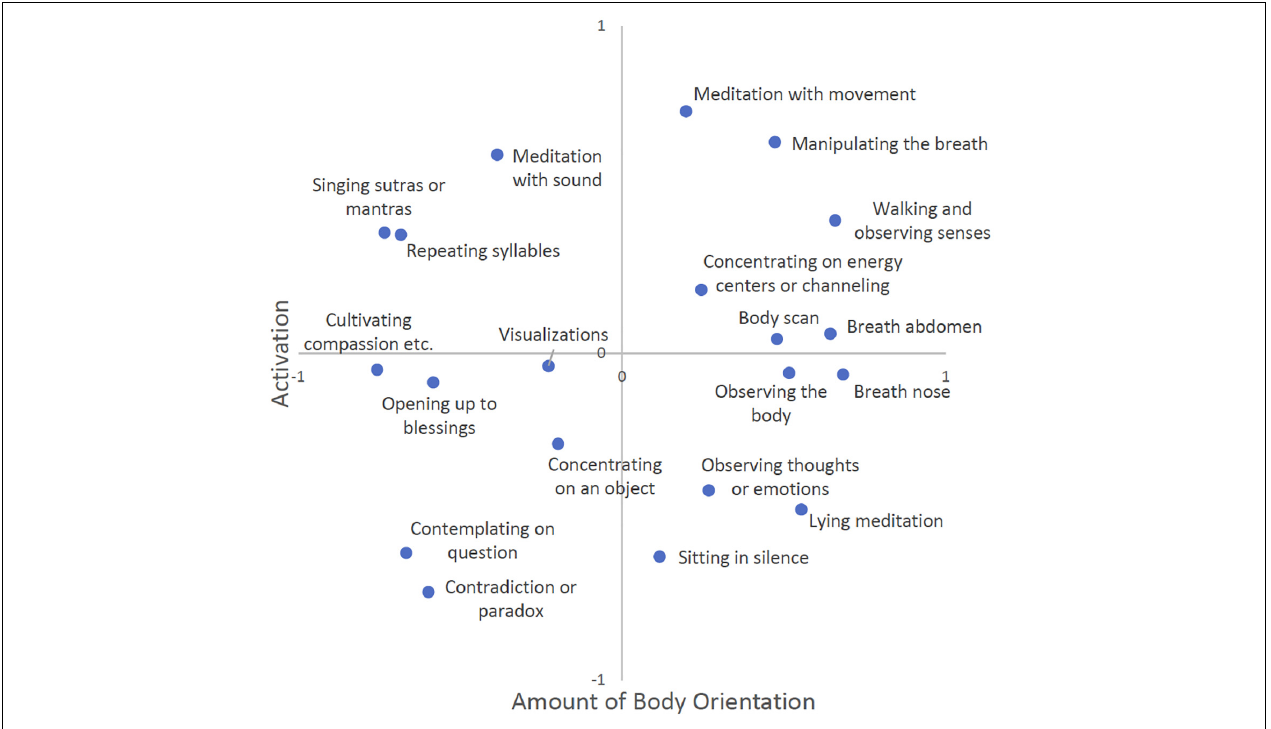
FIGURE 1 | Overall multidimensional scaling (MDS) solution, based on average similarity judgments of N = 100 experienced